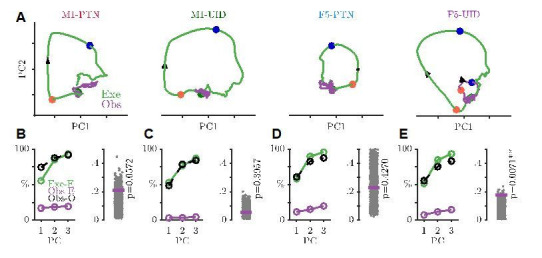
Projections of execution and observation activity onto PG execution subspace, in same format as Figure 7A-D, but showing F5-PTNs and F5-UIDs separately.Firing rates were smoothed using a 25ms Gaussian, and normalization constant was set to 0 (i.e. no soft-normalization).